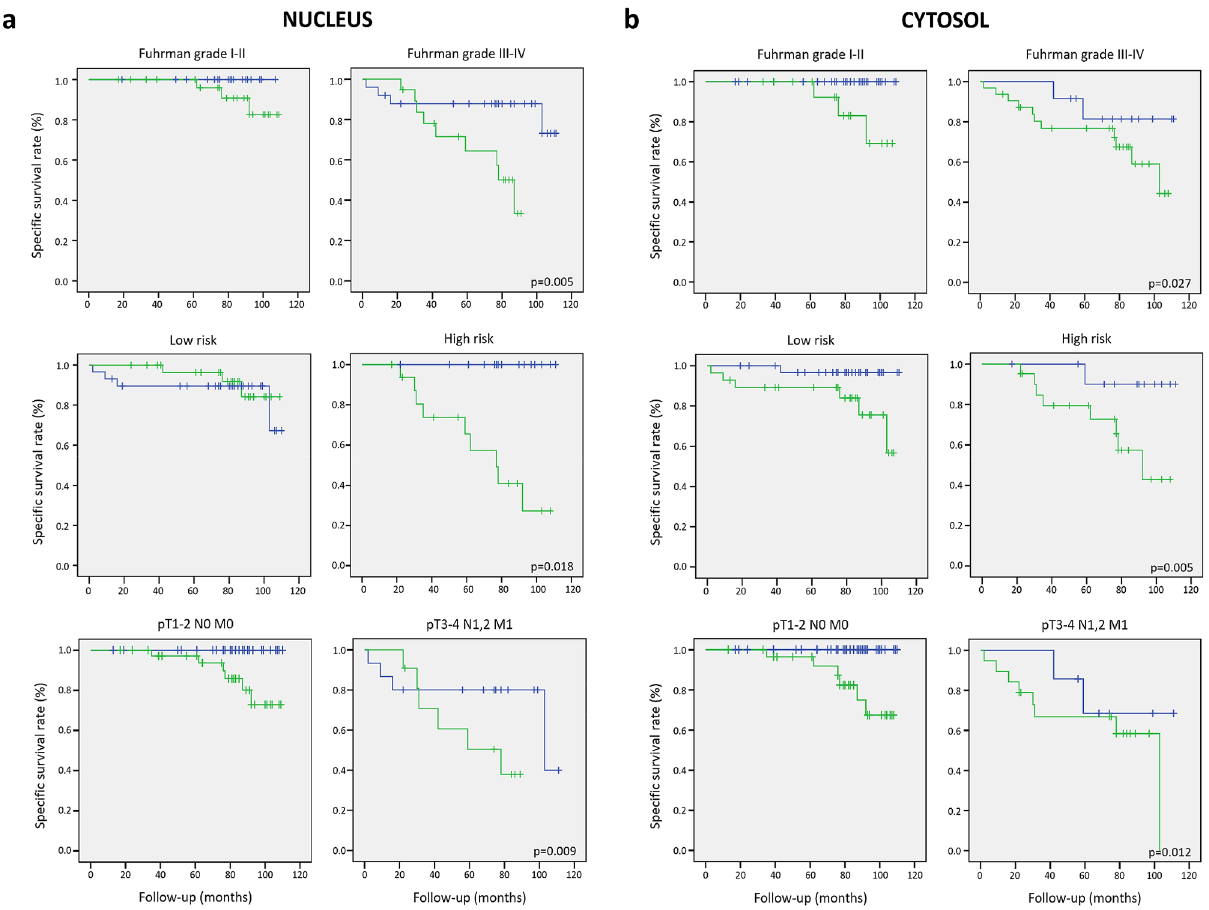
Figure 2. Correlation of pS727-STAT3 H-score with clinical outcome. Kaplan–Meier estimates of 120 months overall survival showing that patients with high pS727-STAT3 H-score (green lines) are prone to die earlier over time when compared to low pS727-STAT3 H-score patients (blue lines), especially those in advanced stages of the disease (Fuhrman grade III–IV, high risk, and tumor size pT3-4 N1,2 M1). Nuclear (blue line, HS < 80; green line, HS ≥ 80) (left panel) and cytosolic (blue line, HS < 40; green line, HS ≥ 40) (right panel) pS727-STAT3 H-score expression levels correlated to mean survival of ccRCC patients according to ( a ) Fuhrman grade (I–II, III–IV), ( b ) risk group (low, high), and ( c ) tumor size (pT1-2 N0 M0, pT3-4 N1,2 M1).